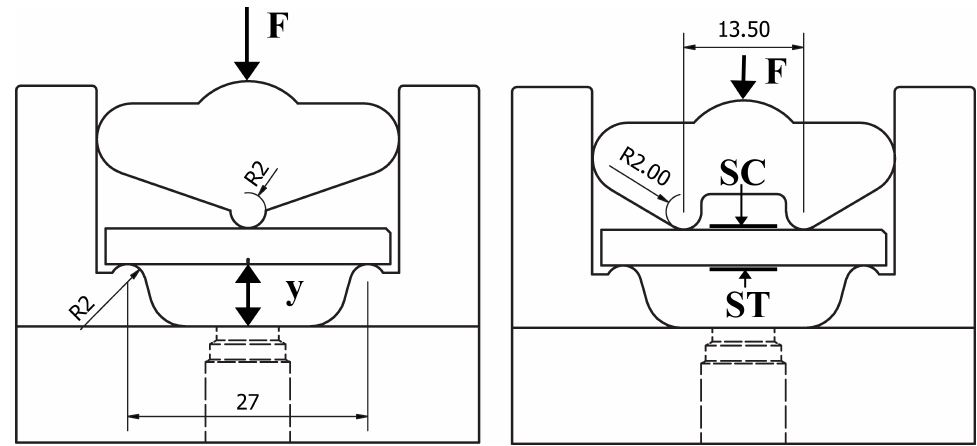
Figure 1. The schematic drawing of the three point bending setup used for fracture toughness measurement and four point bending setup used for stress-strain curve measurement. The loadline displacement y and compressive strain SC at the top face and tensile strain ST at the bottom face of the specimens are marked.